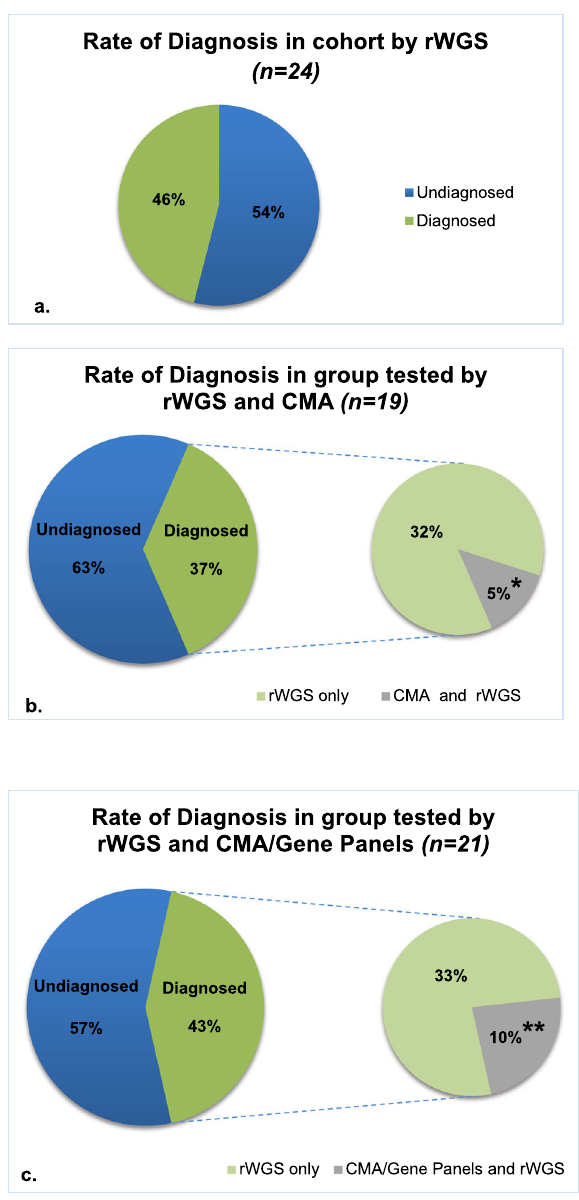
Fig. 2 Rate of genetic diagnosis with rWGS, CMA and gene panels. a – c Rate of Genetic diagnosis with rWGS, CMA and gene panels. a Rate of diagnosis in cohort by rWGS. rWGS had a higher rate of diagnosis (11/24) in the cohort compared to microarray (1/19) and microarray + / − gene panel (2/21). b Rate of diagnosis in group tested by rWGS and CMA. The rate of diagnosis was statistically signi fi cant higher with rWGS compared to microarray ( p = 0.04*; McNemar ’ s Test) when comparing the rate of diagnosis within the group that had both microarray and rWGS testing ( n = 19). c Rate of diagnosis in group tested by rWGS and CMA/Gene Panels. When comparing the rate of diagnosis of rWGS within the group that received microarray + / − gene panels testing ( n = 21) and rWGS, rWGS still outperformed in yielding a diagnosis ( p = 0.02**; McNemar ’ s